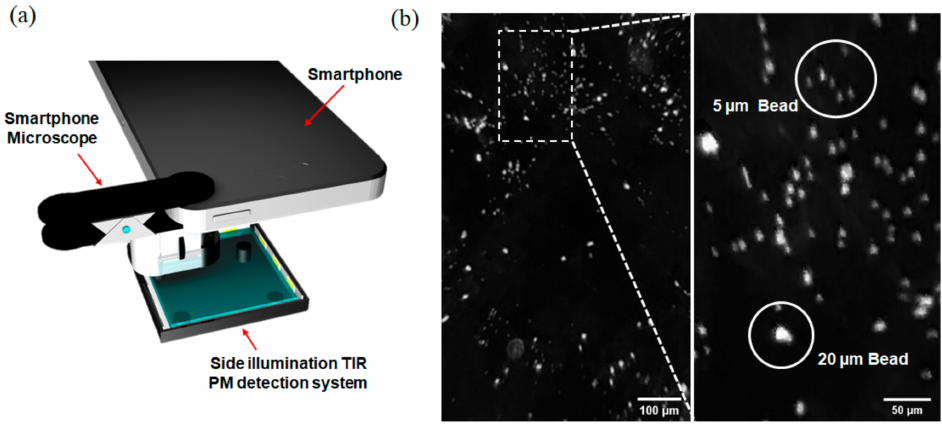
Figure 6. Side-illuminated TIR PM detection system paired with smartphone. Configuration of the smartphone camera attached with a smartphone toy microscope ( a ) and captured images from it ( b